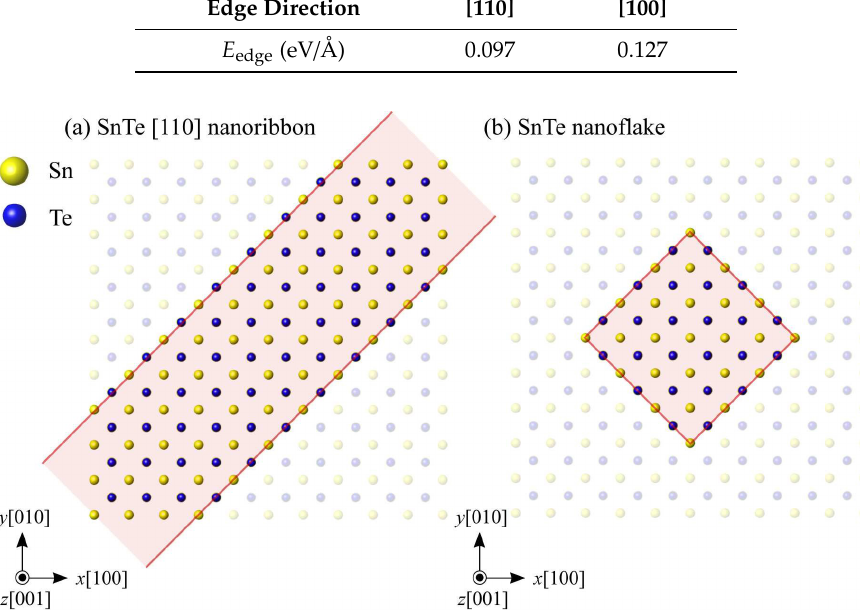
Table 1. Calculated edge formation energy E edge of [110] and [100] edge in layered SnTe.